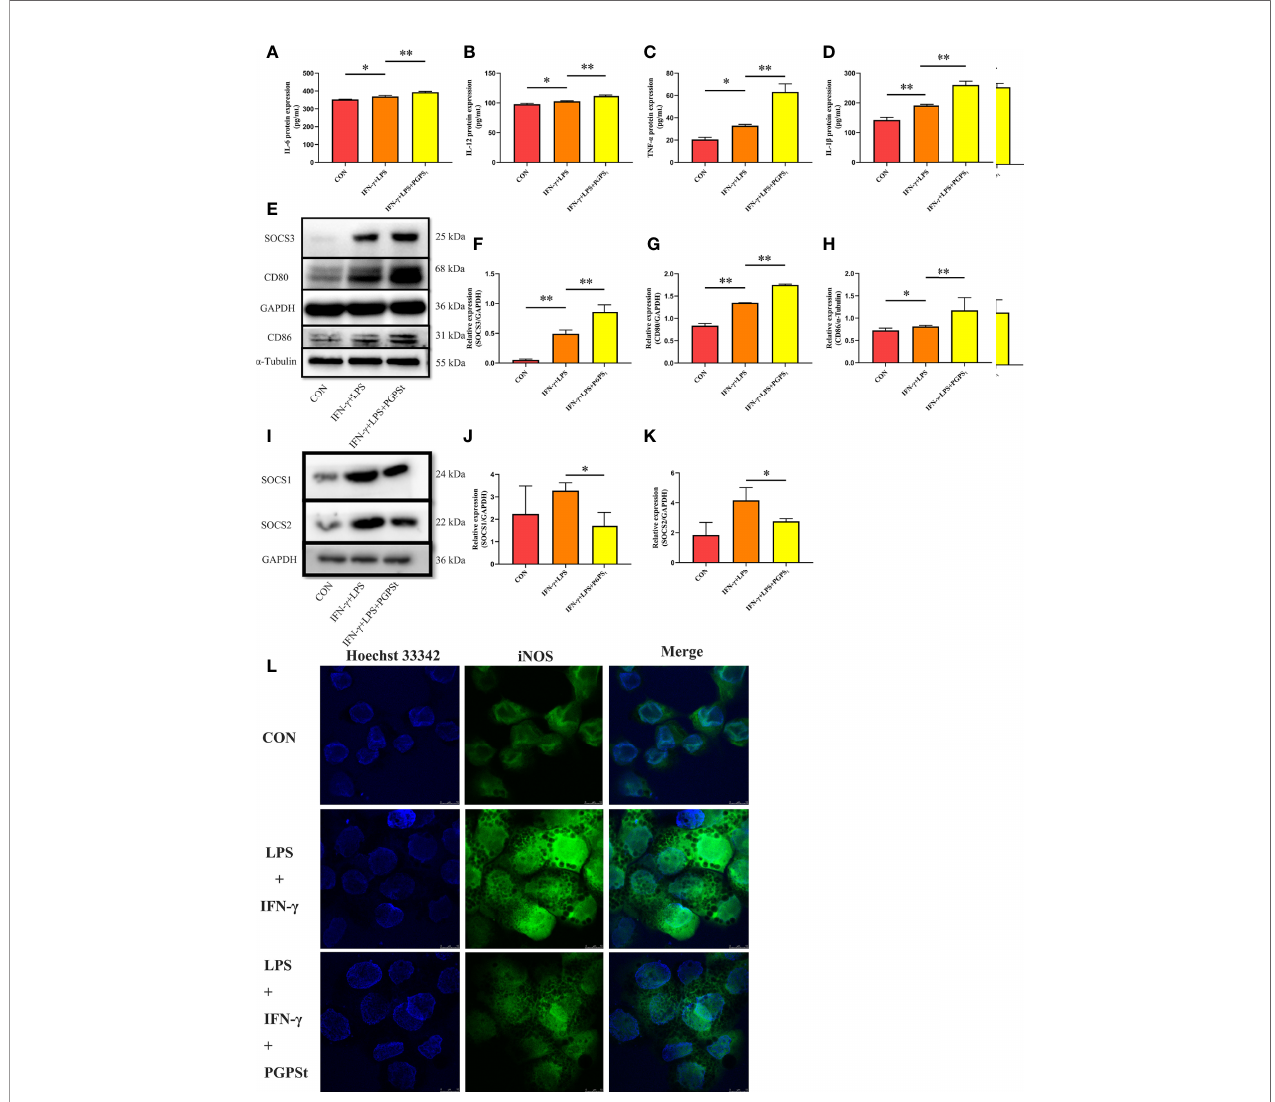
FIGURE 3 | Expression changes of M1 marker protein in 3D4/21 cells treated with LPS/IFN- g or PGPS t for 24 h. (A – D) The expression of M1 marker proteins in different activated 3D4/21 cells was analyzed by the ELISA kit. (E – H) 24 h after stimulation, Western blot analysis of M1 marker protein expression in 3D4/21 cells; (I – K) Western blot analysis of protein expression regulated by the polarization pathway in 3D4/21 cells. (L) Approximately 24 h after stimulation, the proportion of cells expressing iNOS (the marker of M1-type 3D4/21 cells) was monitored by a laser confocal microscope. Means ± SD are indicated (n = 3). * indicates P < 0.05; ** indicates P <